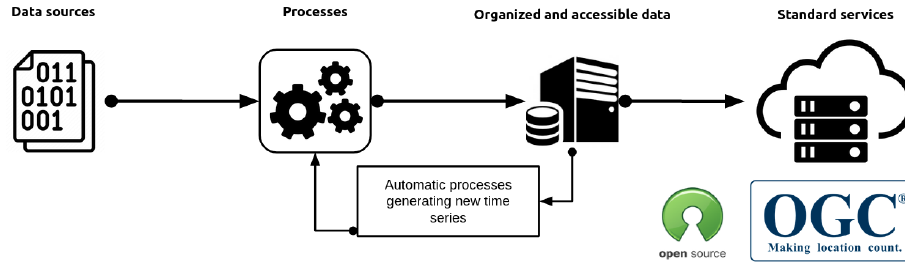
Figure 2. The data flow architecture.